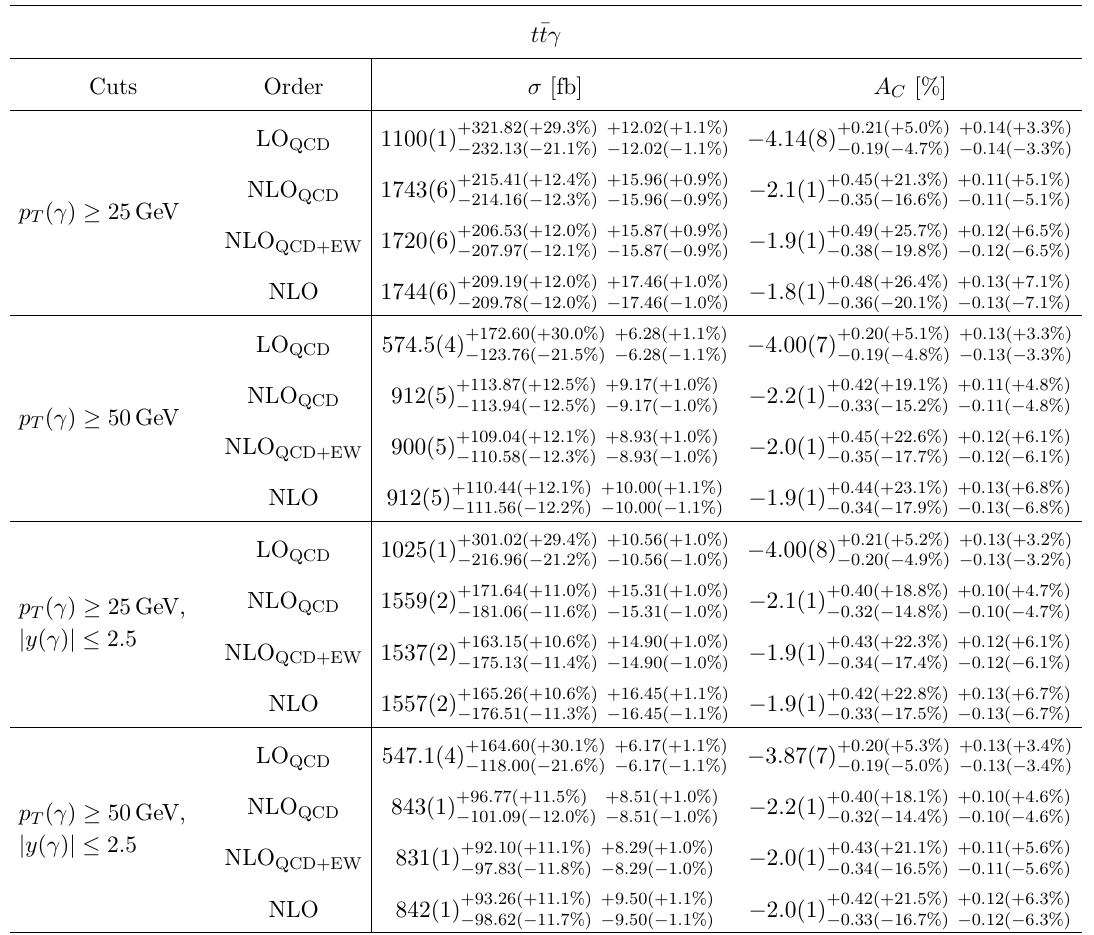
Table 1 . Cross sections and charge asymmetries for t ¯ tγ production. The uncertainties are respec- tively the scale and the PDF ones in the form: ± absolute size ( ± relative size). The first number in parentheses after the central value is the absolute statistical